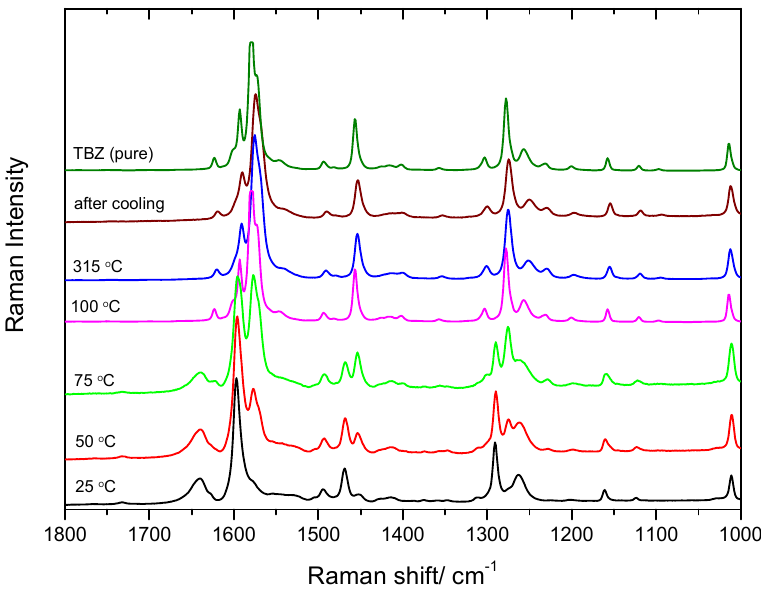
Figure 18. Raman spectra of TBZ–formic acid solvate at 25 °C, 50 °C, 75 °C, 100 °C, and 315 °C; after gradual cooling of the sample a spectrum was collected.